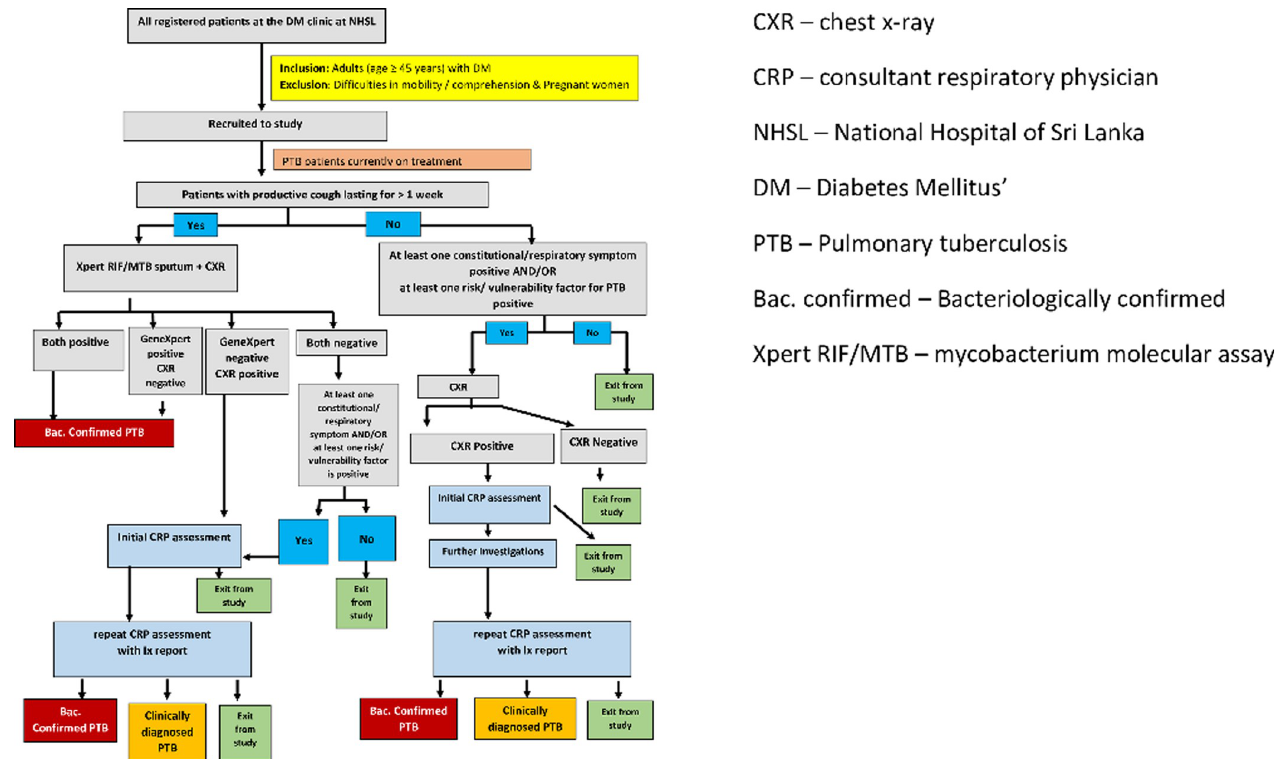
Fig 1. Algorithm used to detect cases of pulmonary TB among attendees of DM